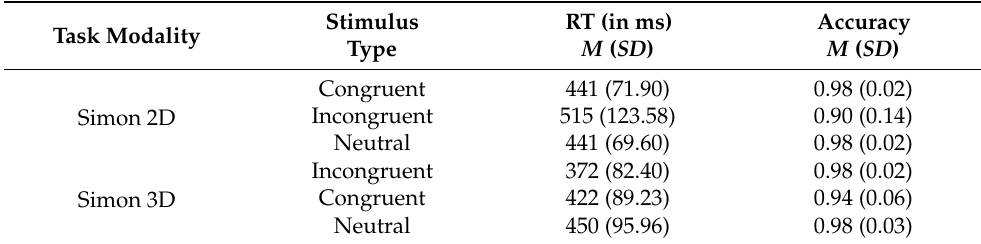
Table 2. Mean accuracy proportions and reaction time (RT) results per condition, task version, and task. Standard deviation is presented in parentheses.